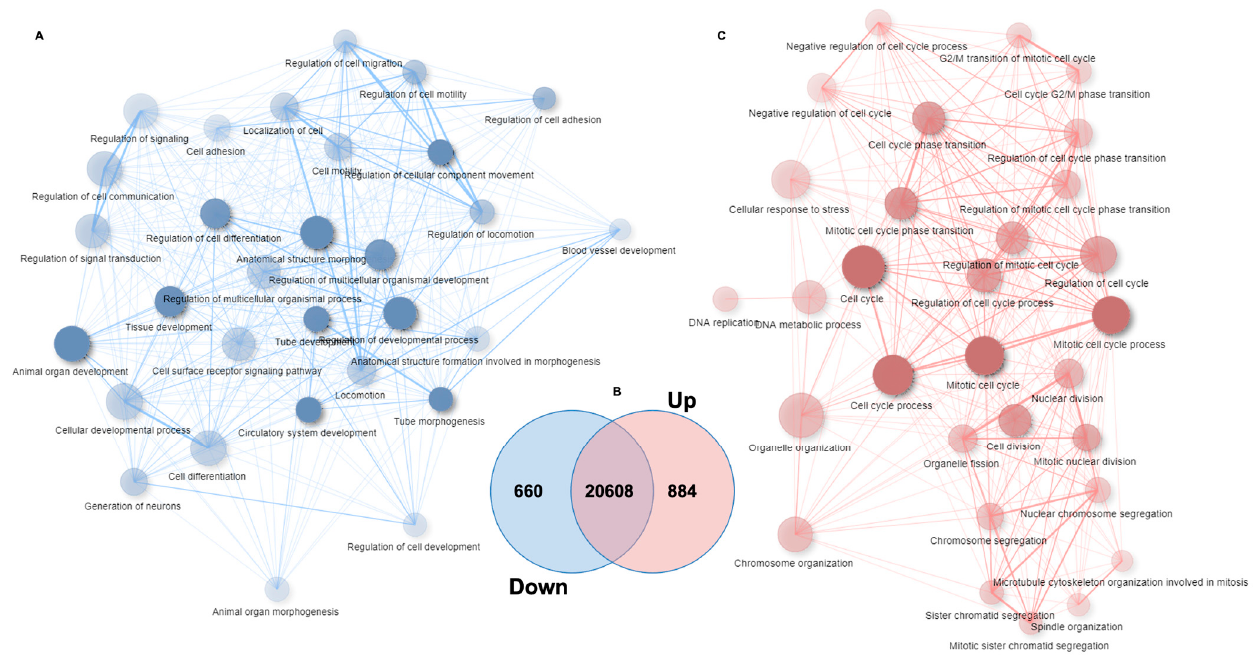
Figure 6. DEG analysis in KCs overexpressing miR-21-3p versus negative control. ( A , C ) Functionally grouped networks for significant downregulated genes (blue) and upregulated genes (red). Only the labels of the 30 most significant terms per group are shown. Each node represents an enriched GO term. Related GO terms are connected by a line, the thickness of which reflects the percentage of overlapping genes. The size of the node corresponds to the number of genes. The network was automatically laid out using the ShiniGo tool with an edge cut ‐ off of 0.2. Data information: data are representative of experimental triplicates per condition. ( B ) Venn diagram. showing the extent of overlap among all expressed genes between the miR ‐ 21 ‐ 3p overexpressing HaCaT cells versus NCs. The level of significant gene modulation was p.adjusted < 0.05.